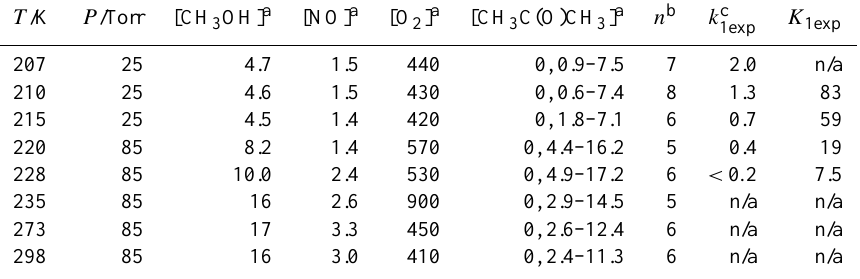
Table 2. Experimental conditions and estimated k 1exp and K 1exp